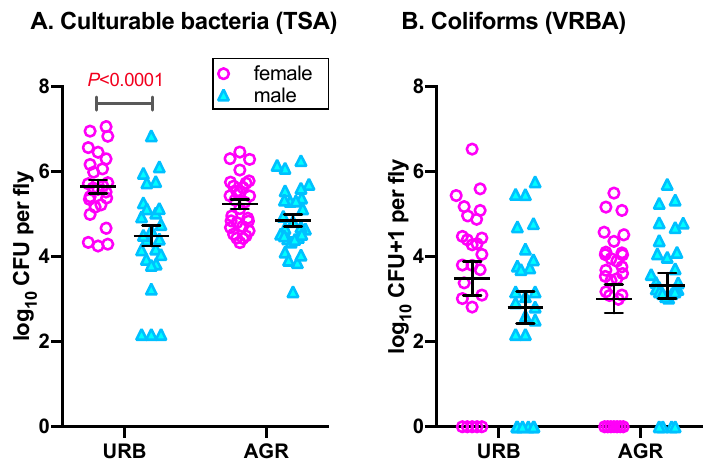
Figure 1. Bacterial abundance in female and male house flies collected from urban (URB) and agricultural (AGR) environments. ( A ) Culturable CFUs isolated on tryptic soy agar (TSA); ( B ) Coliform CFUs isolated on violet red bile agar (VRBA). Mean Log 10 CFU, standard errors and significant differences in means are shown. Statistical analysis details are in the text.